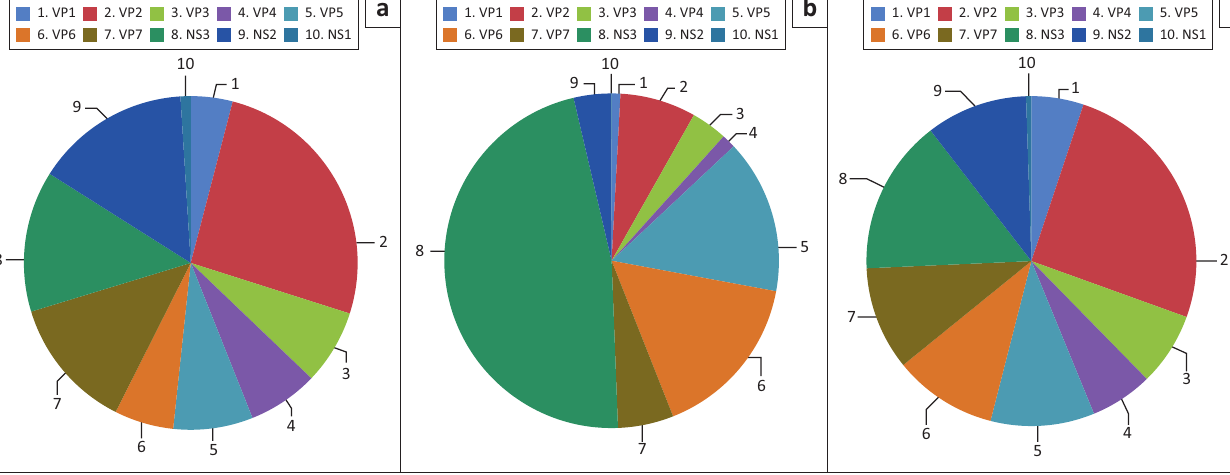
FIGURE 4: Proportional representation of paired-end sequence reads mapping to each segment after the third round of panning with anti-African horse sickness virus-4 IgG. (a) Day 0, (b) day 28 and (c) day 52. Data represent the average of the five horses for each time point. Segments are colour coded and named according to their encoded